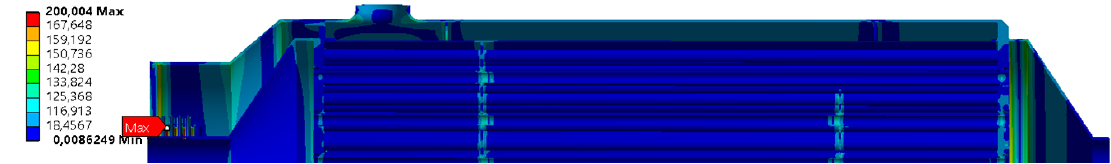
Figure 4: Calculation results. Fragments with the highest stresses, MPa.